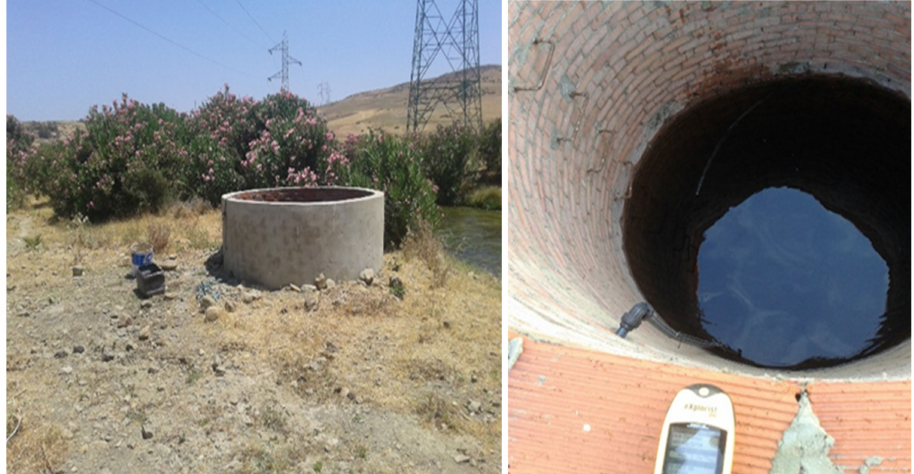
Figure 2. Figure showing some Jouamaa Hakama wells, which are used for the population’s daily